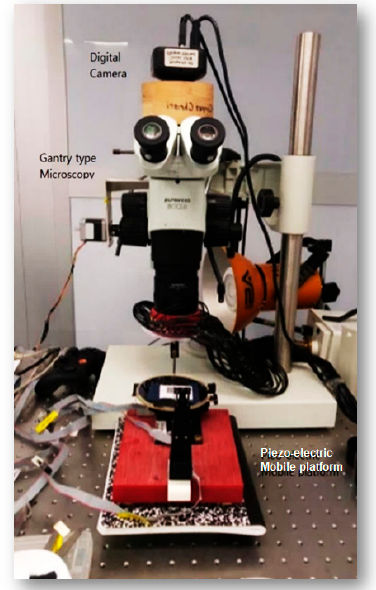
Figure 3. Experimental setup for microscale SfM.